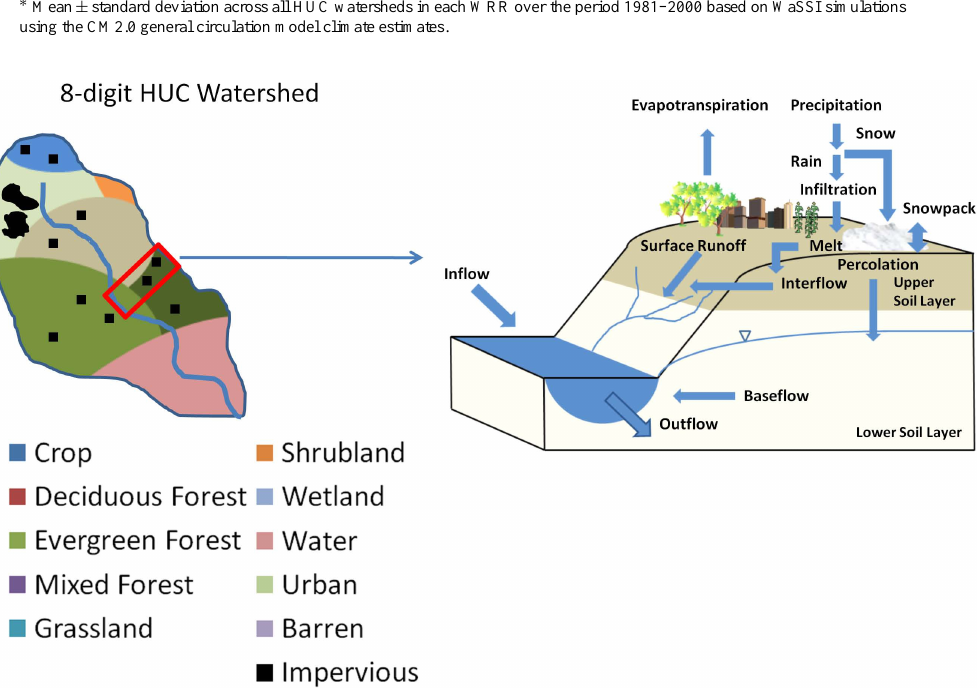
directly to the watershed